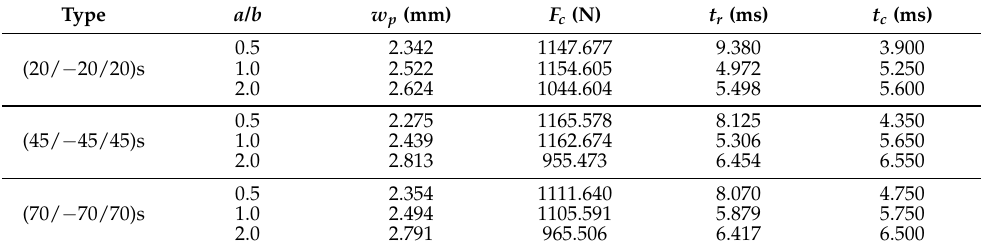
Table 9. Low-velocity impact response of a sandwich structure with various a / b .